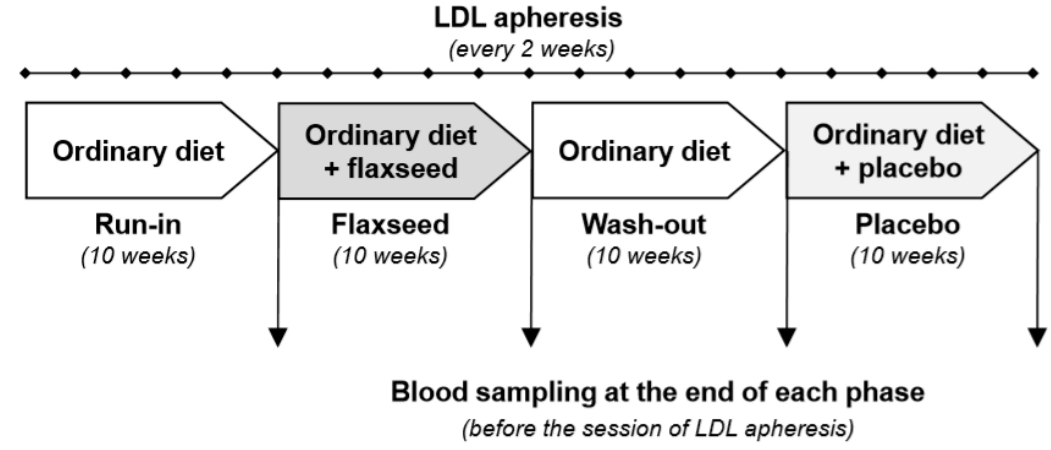
Figure 1. A protocol of the study. LDL, low-density lipoprotein.